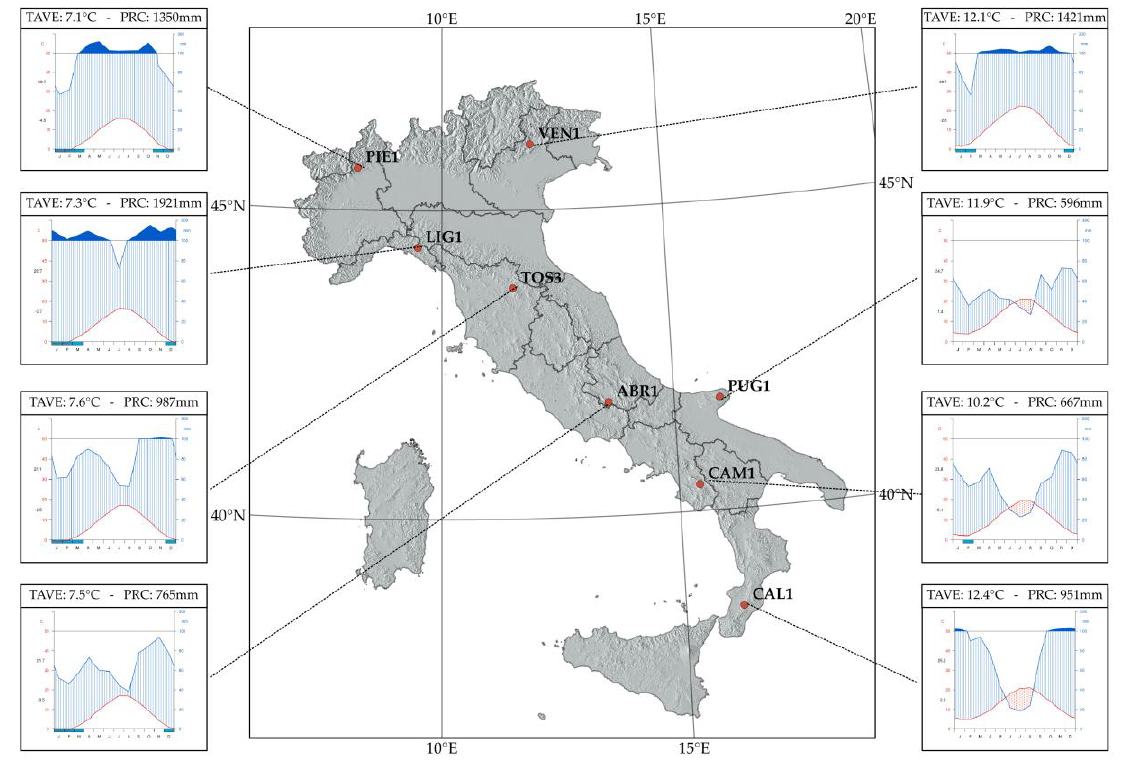
Figure 1. Spatial distribution of beech ICP-Forests plots in Italy and Walter &Liethclimatic diagrams for each study site. Climatology was elaborated as the average value of the last available normal climatic period (1981–2010). Average annual temperature (TAVE) and total annual precipitation (PRC) are written at the top of each diagram.